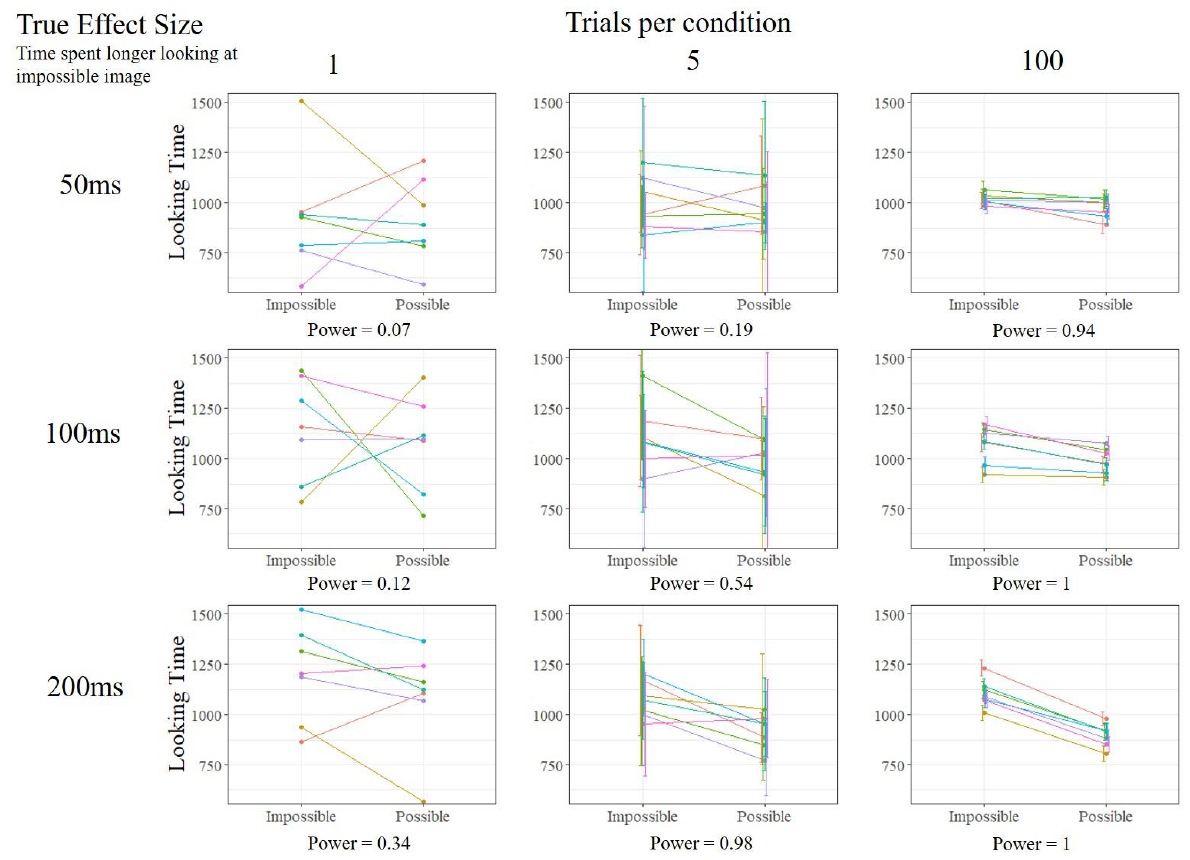
Figure 1 . Graphs showing example data from nine different designs of a looking-time experiment in rooks. These designs vary on the underlying effect size (50 ms, 100 ms, 200 ms), and the number of trials per condition (1, 5, 100). N = 7 for all designs. The power of each design is printed below each graph and was calculated by simulating 10,000 studies in each design and calculating the proportion of p -values less than